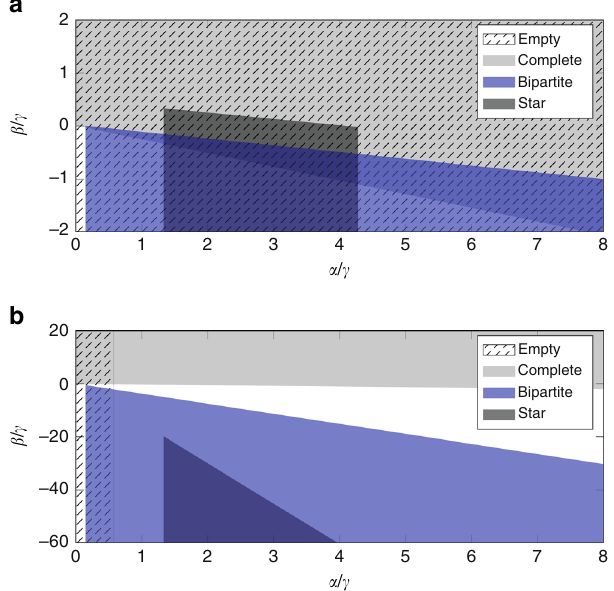
Fig. 5 Phase Diagram comparison. a Nash and b Pairwise-Nash equilibrium comparisons of different network motifs of N ¼ 50 agents and for δ ¼ 0 : 5.